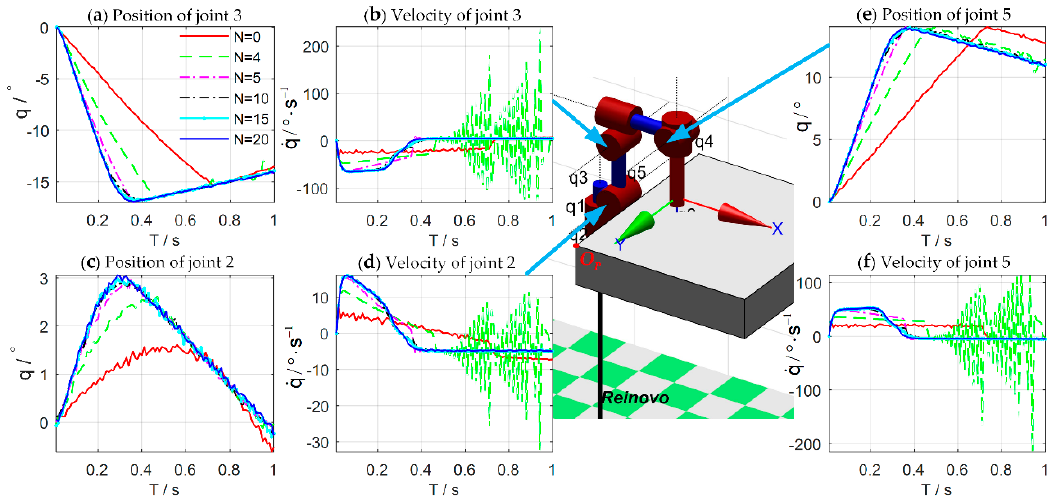
Figure 10. Joint trajectories after 4, 5, 10, 15, and 20 updates for the second, third, and fifth joint of the Reinovo robot.